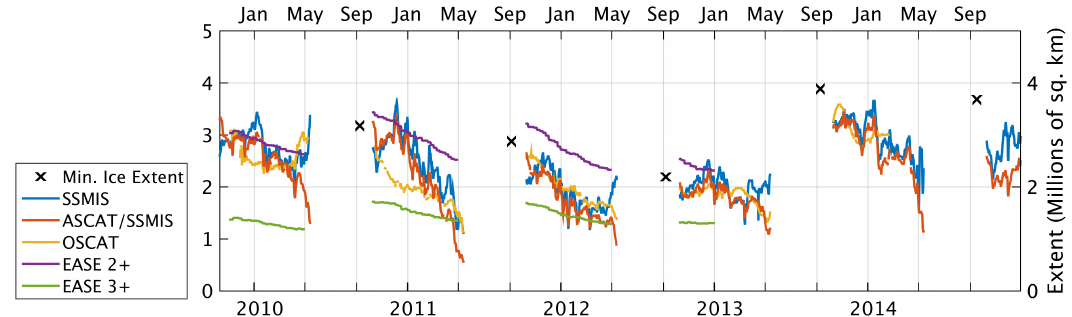
Figure 8. Time series of minimum total ice extent and MY ice extent. Plots are shown of the MY ice extent from SSMIS-only, ASCAT/SSMIS, and OSCAT ice classifications, as well as the extent of old ice including (EASE 2+) and excluding (EASE 3+) second-year ice as taken from the NSIDC EASE-Grid Sea Ice Age dataset. The annual total ice extent minima are calculated using a 40% ice concentration ice edge as reported by a NASA Team ice concentration product [31]. The average standard deviation for the ASCAT/SSMIS MY extent over 60-day windows is 192 thousand km 2